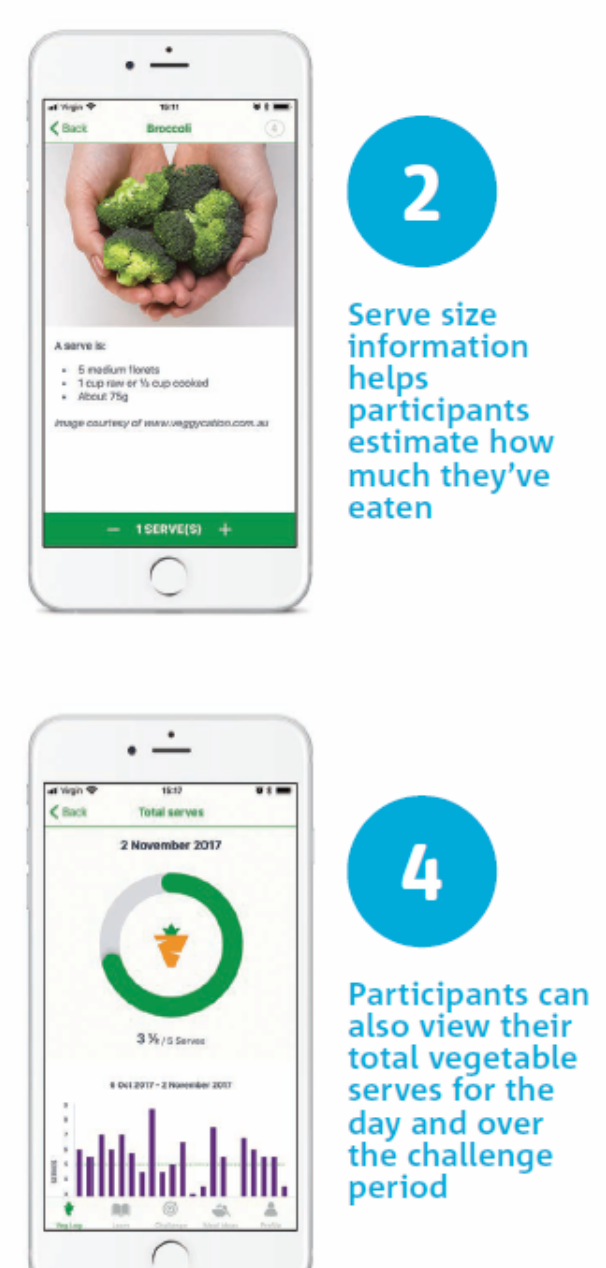
Figure 1. Vegetable log feature as a core component of the VegEze